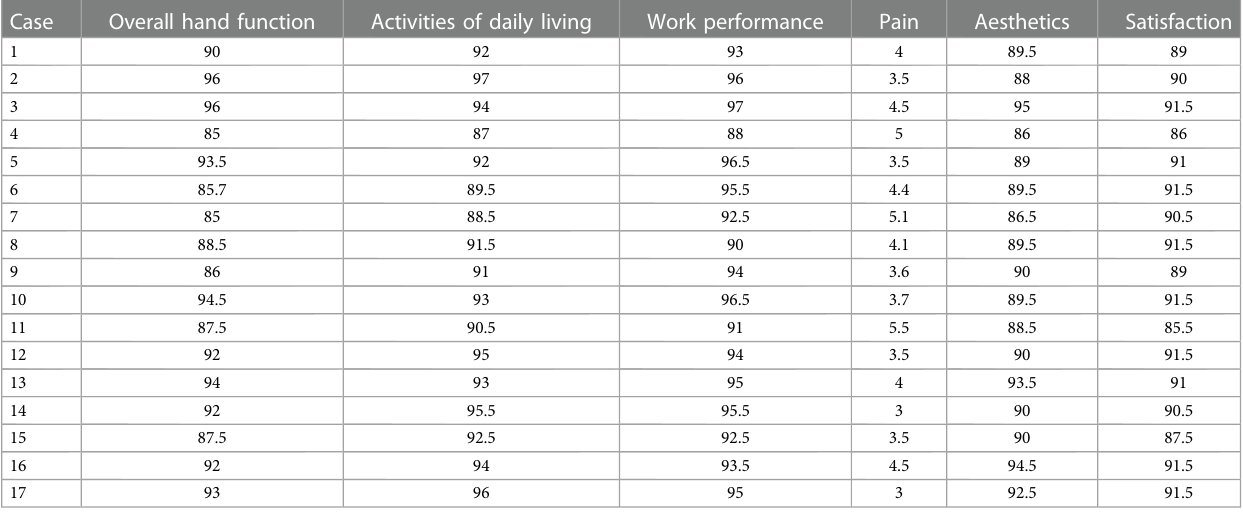
TABLE 3 Postoperative assessment of subjective evaluation ( fi ve domains of the MHQ). Case Overall hand function Activities of daily living Work